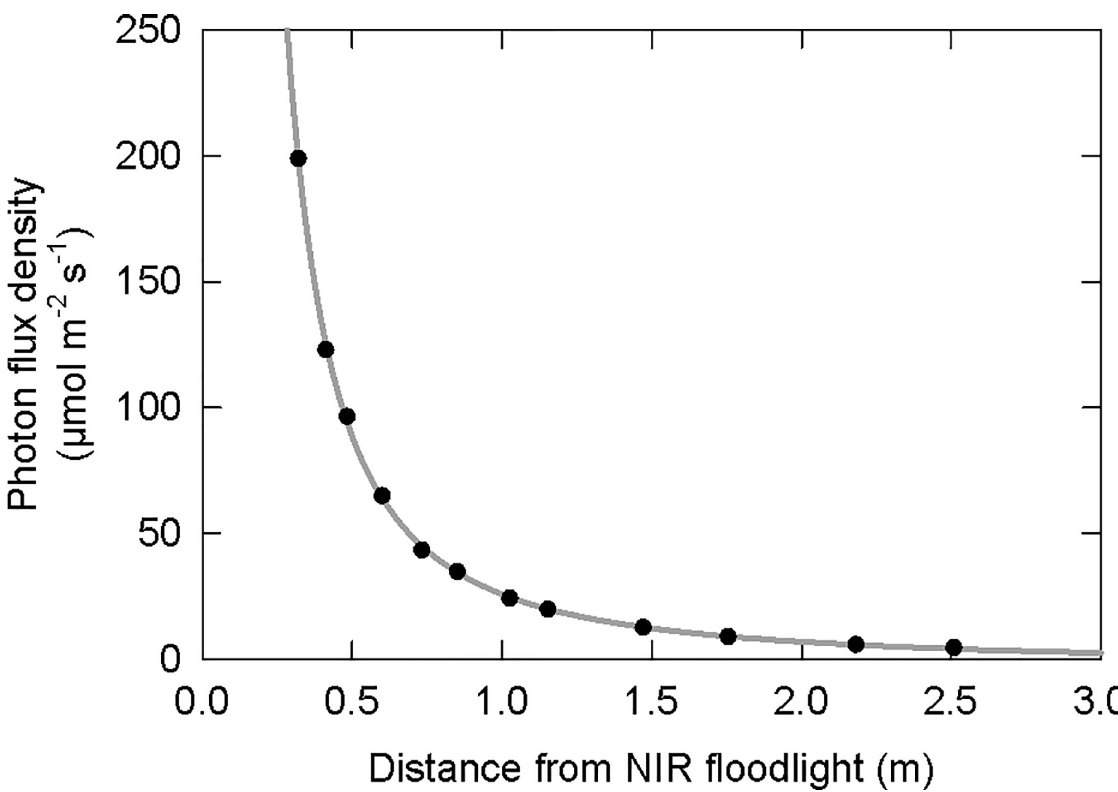
Fig 6. Total photon flux density from an NIR LED floodlight as a function of distance. These measurements were made directly below the floodlight at increasing distances, and they follow the inverse square law.